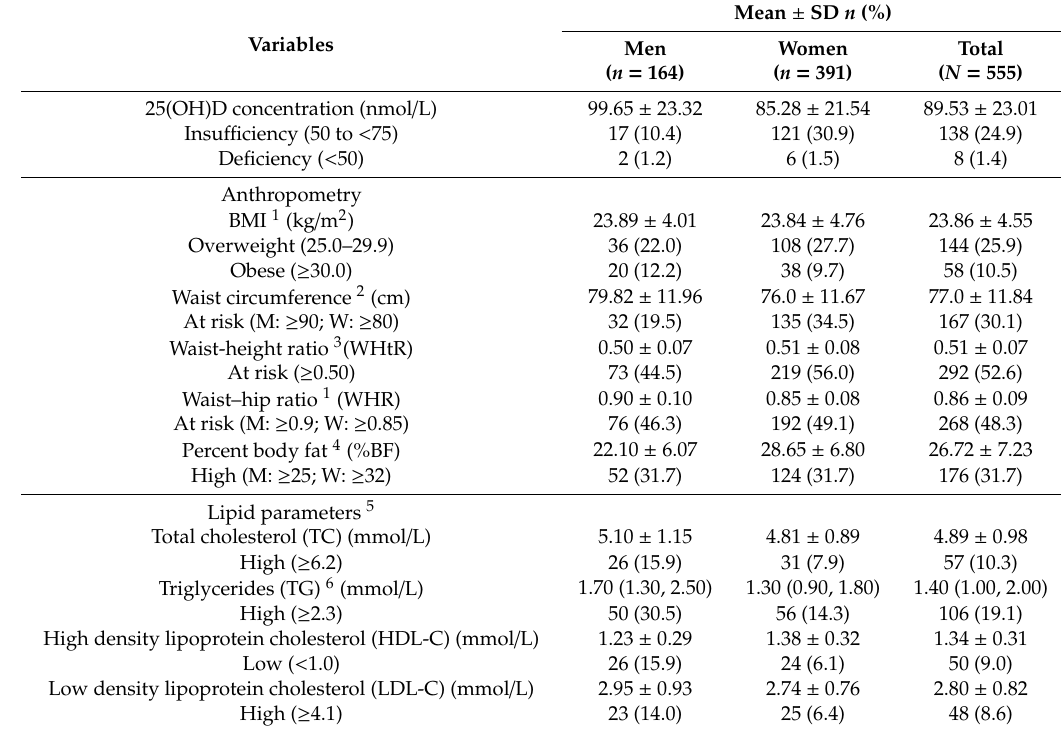
Table 2. Anthropometric and biochemical variables of respondents by